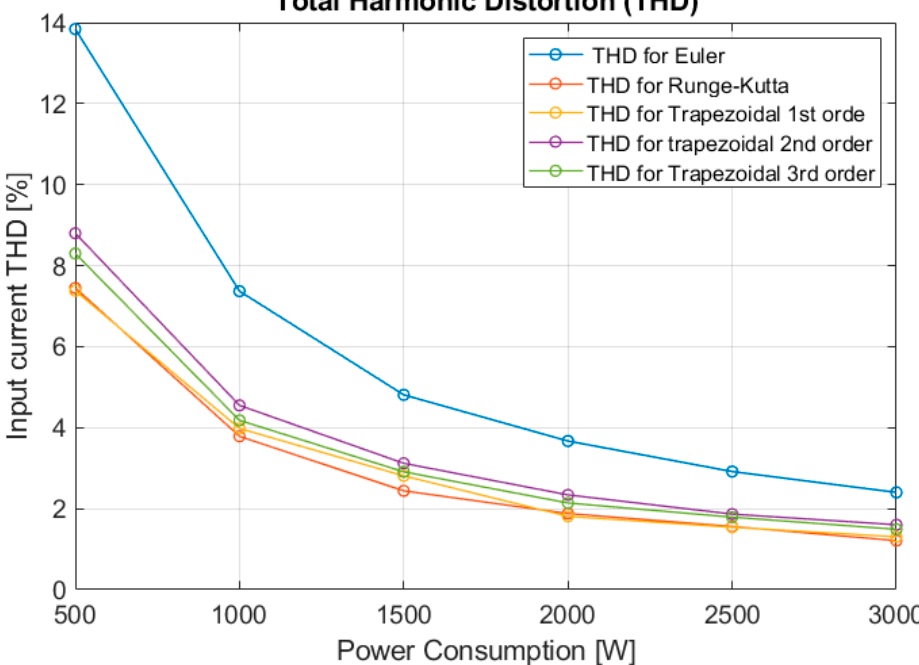
Figure 17. THD obtained using the obtained approximations for different output power.